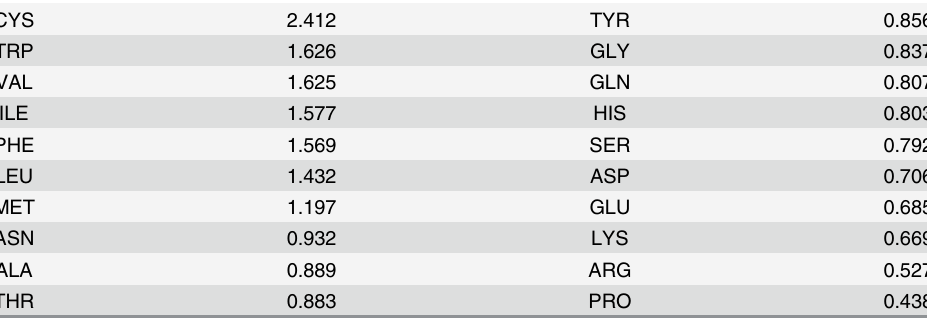
Table 1. Incidence of residues on key